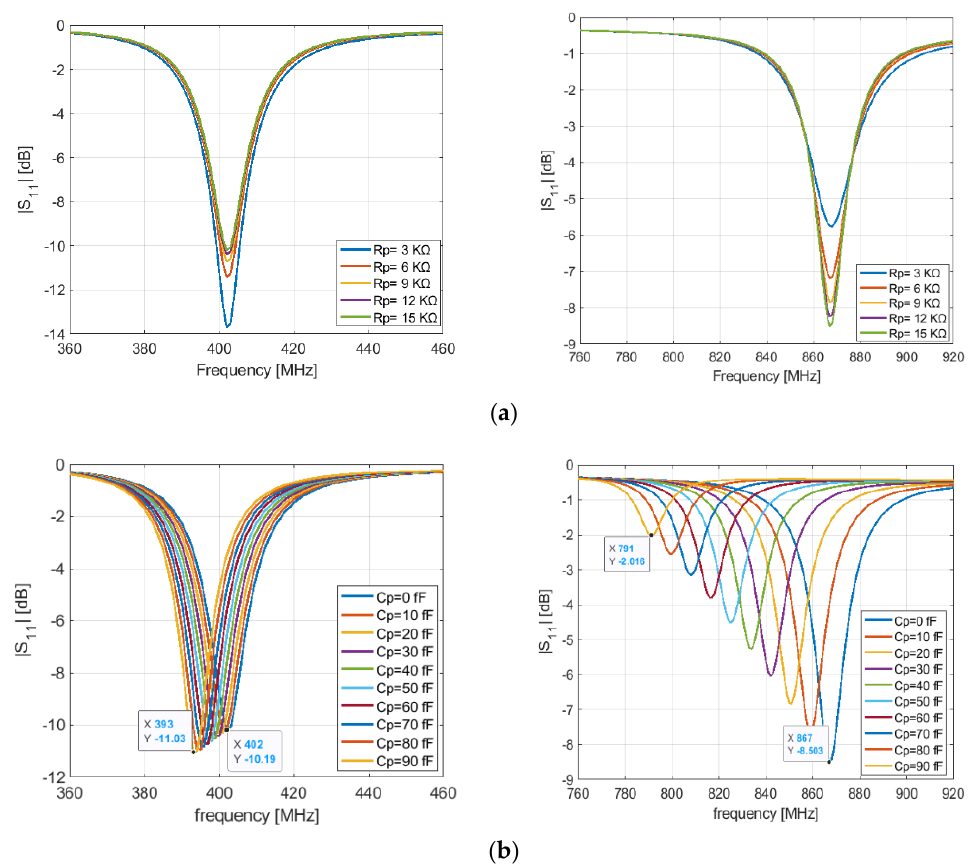
Figure 6. Simulated input reflection coefficient of the antenna with variated parameters of the PIN diode: ( a ) variation of Rp; ( b ) variation of Cp.